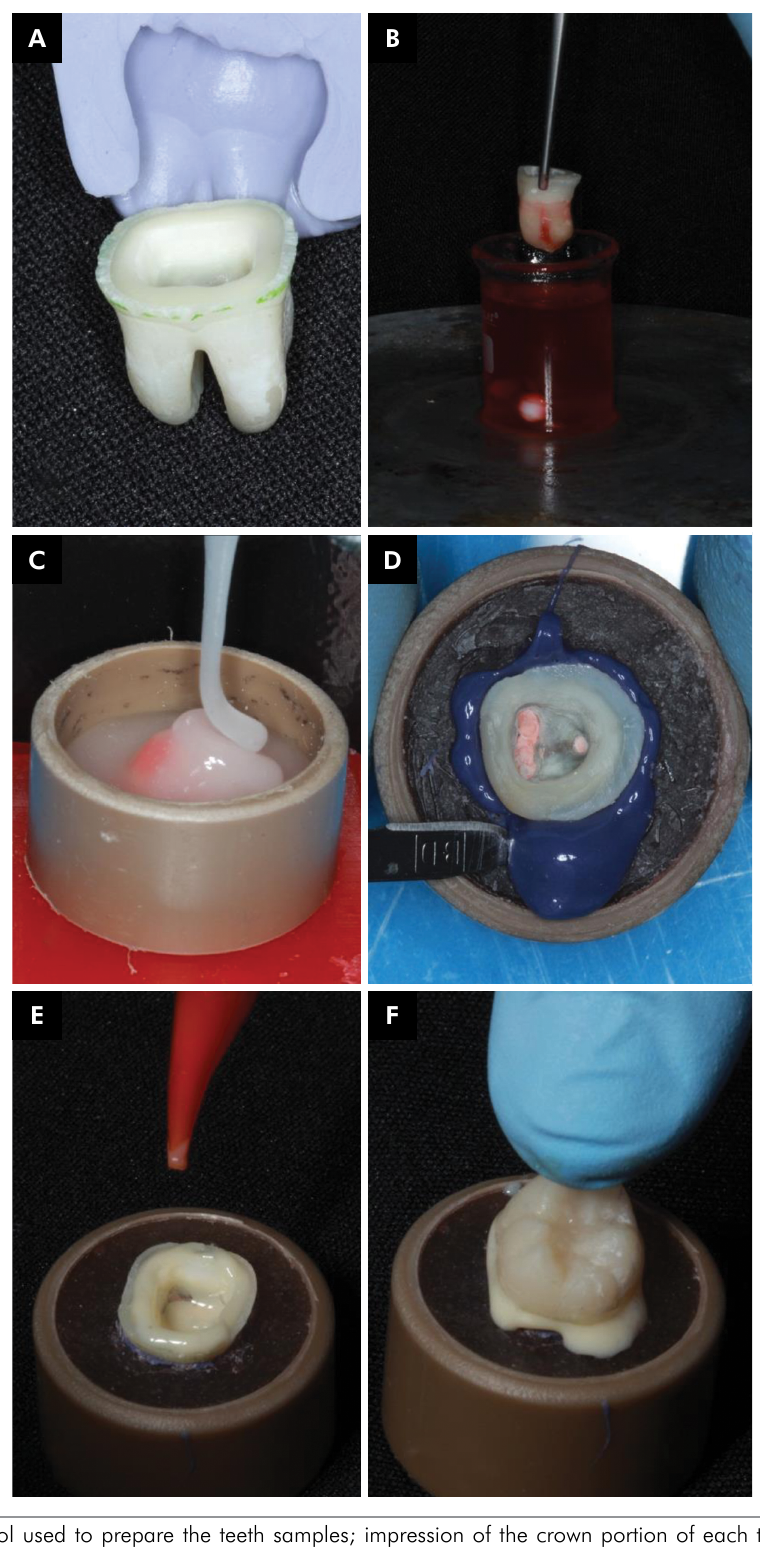
Figure 1. Brief protocol used to prepare the teeth samples; impression of the crown portion of each tooth before crown/root separation (a); wax application on each root surface at 2.0 mm below the cementoenamel junction (b); alveolus simulation made with acrylic resin (c); periodontal ligament simulation made with polyether impression (d); endocrown cementation using self-adhesive resin cement and Centrix ® syringe (e); and pressure of the restoration for 6 min before light-activation (f).